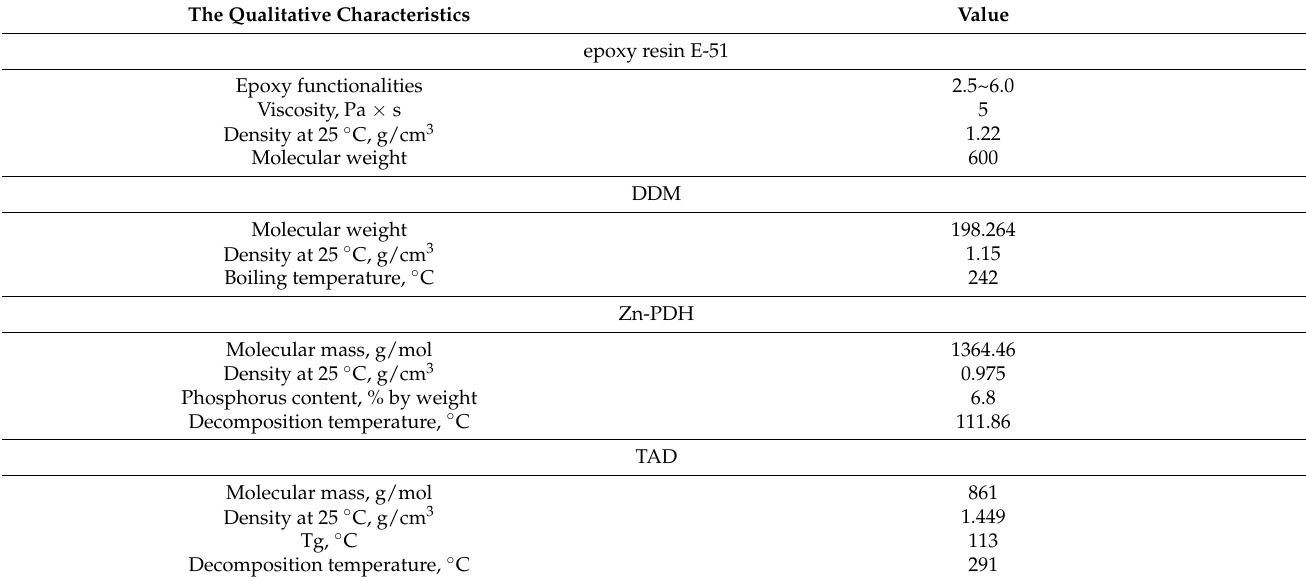
Table 8. Physicochemical and technological properties of components.